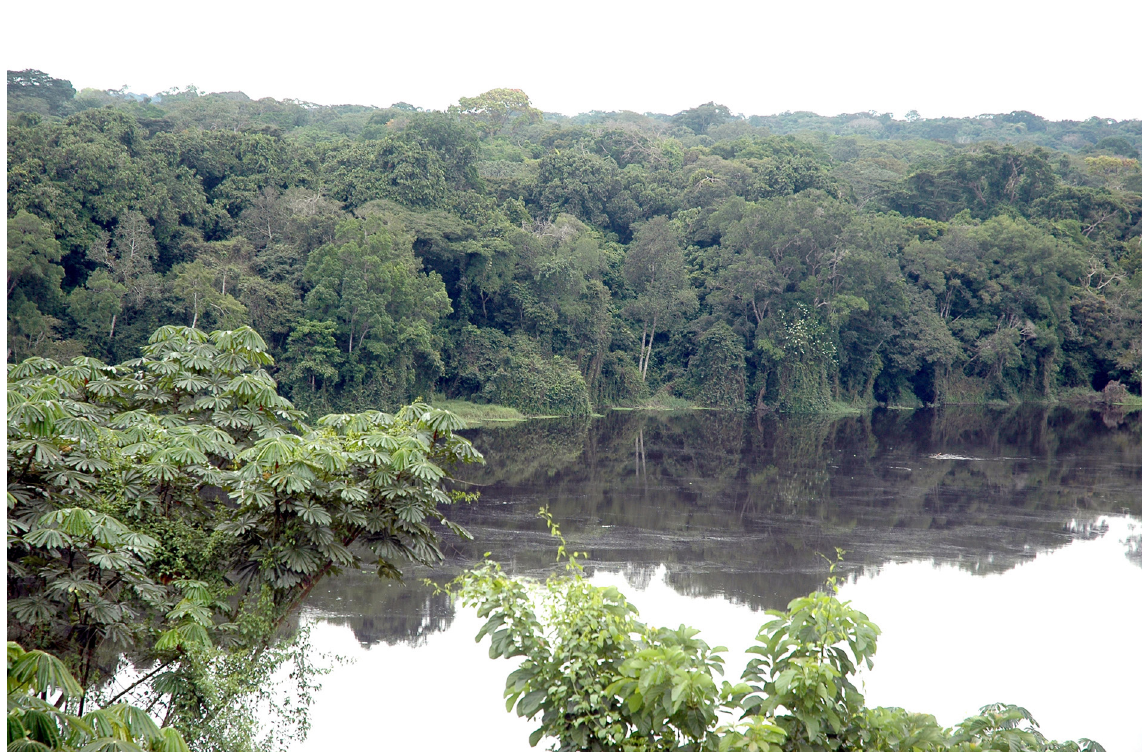
Fig. 1. Primary forest on the Ivindo River at the Ipassa research station. Courtesy of Piero